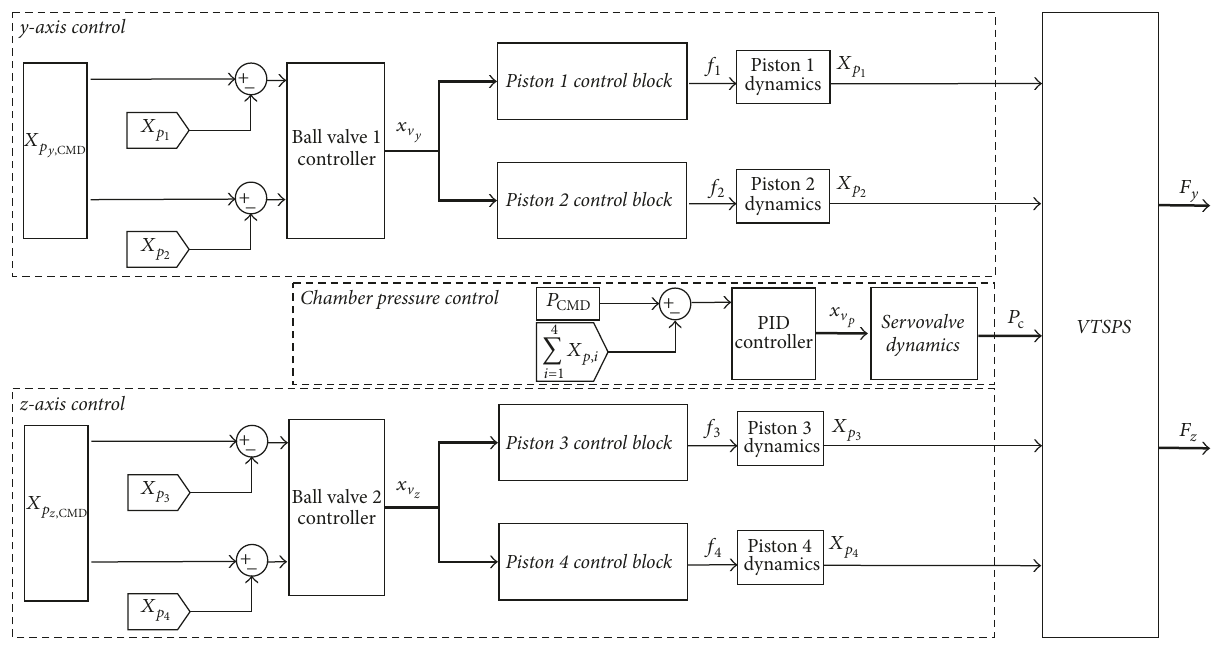
Figure 13: Simulation configuration for 4 nozzles.